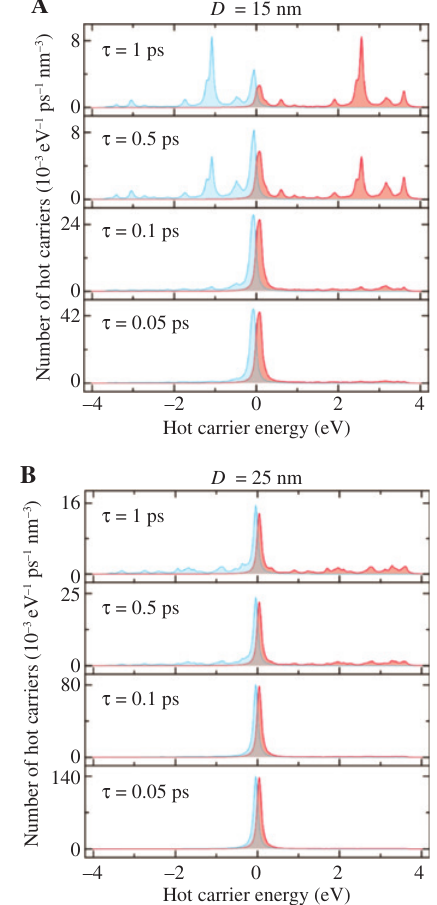
Figure 3: Theoretical modeling of the hot carrier distribution as a function of their energy in AgNPs with diameters of (A) 15 nm and (B) 25 nm. An abundance of hot electrons (red) and holes (blue) are generated via plasmon decay in the 15 nm particle, whereas the hot carrier generation is significantly diminished in the 25 nm